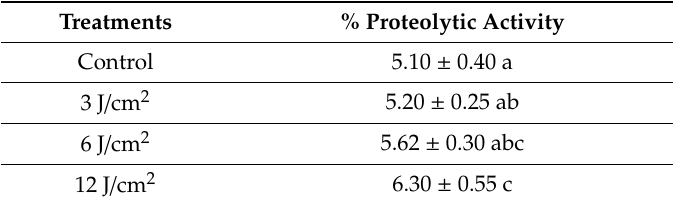
Table 4. E ff ect of red laser beam on proteolytic activity by L. casei before (control) and after exposure to laser